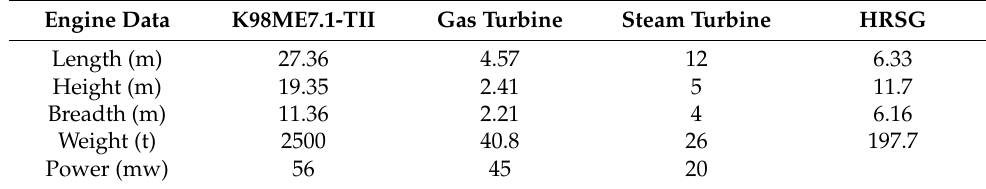
Table 9. Data for the considered prime movers.